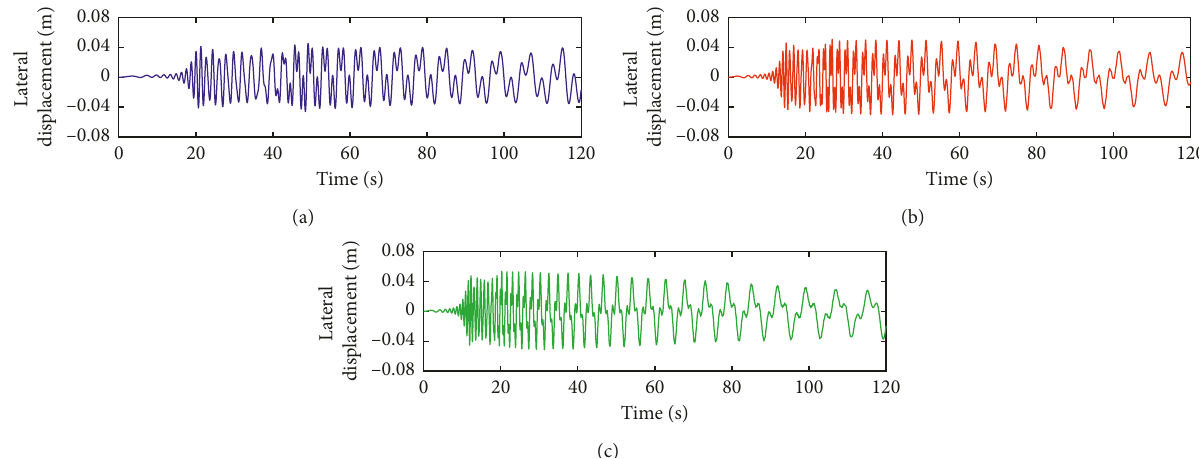
Figure 6: Lateral vibration displacements at l ( t ) /2 of the vertical rope in lowering. (a) The first-order excitation of head sheave axial v wobbles. (b) The second-order excitation of head sheave axial wobbles. (c) The third-order excitation of head sheave axial wobbles.